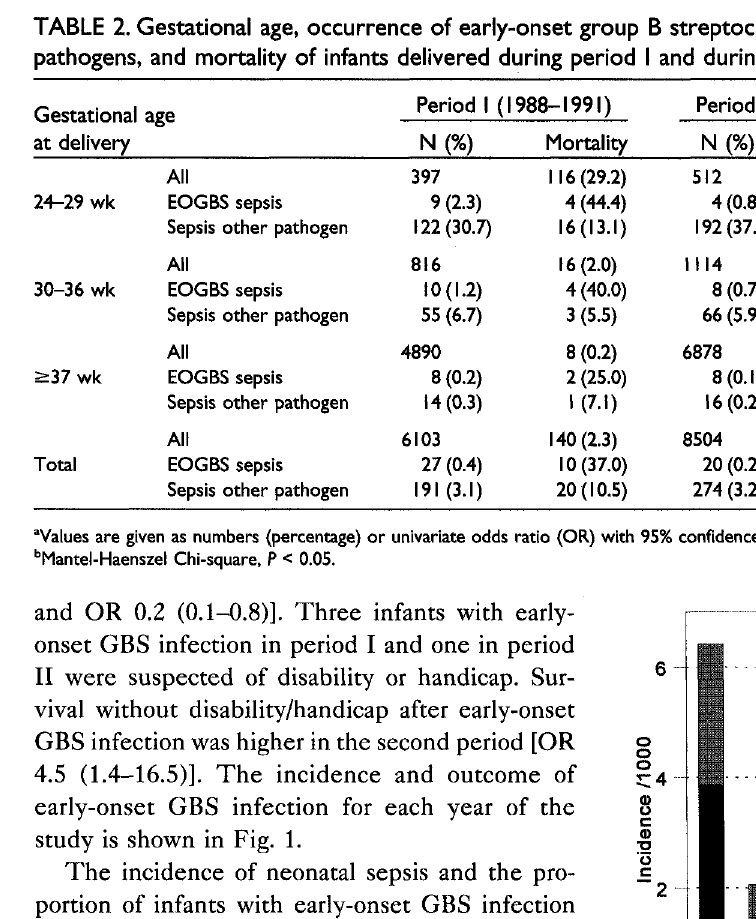
TABLE 2. Gestational age, occurrence of early-onset group B streptococcus (EOGBS) sepsis, sepsis by other pathogens, and mortality of infants delivered during period and during period II Gestational age